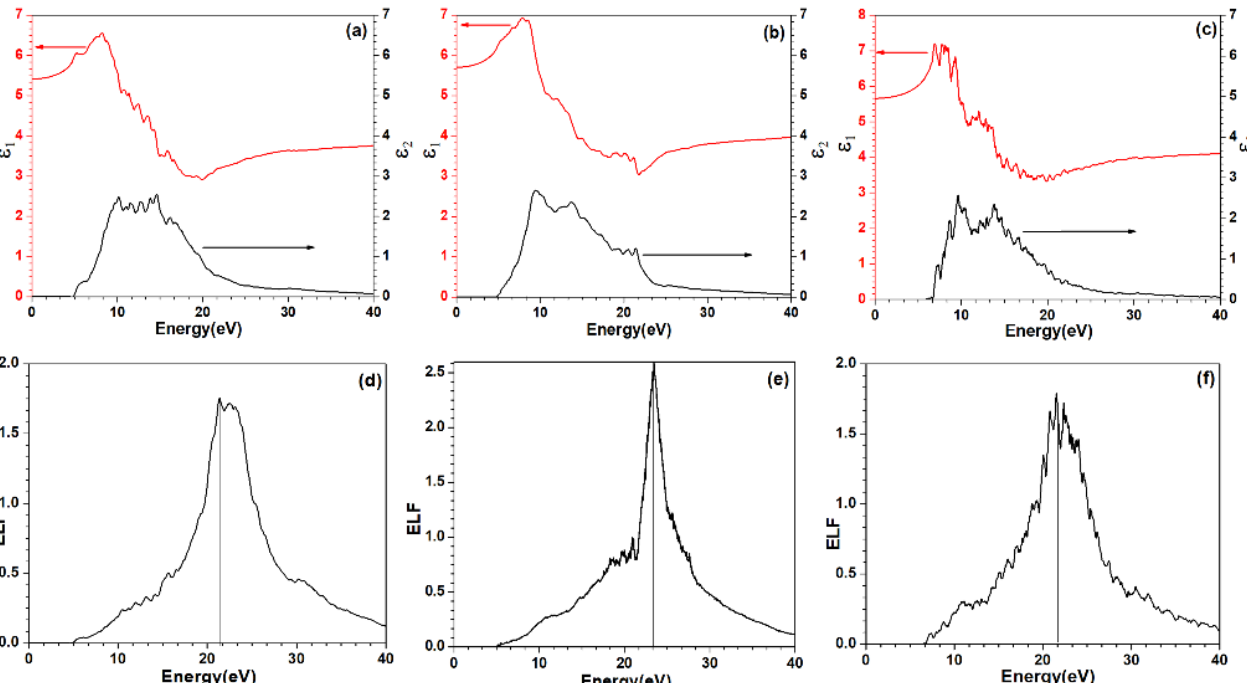
Figure 6. Optical dielectric function for the crystals from ( a ) kaolinite, ( b ) muscovite, and ( c ) montmorillonite. The black curve is for the real part ( ε 1 ); the red curve is for the imaginary part ( ε 2 ). ( d – f ) show the energy-loss function for kaolinite, muscovite, and montmorillonite, respectively.